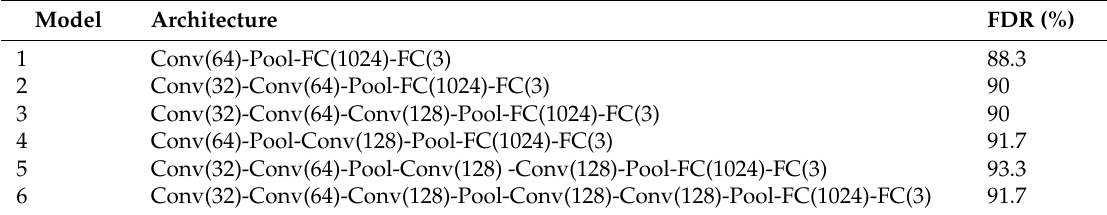
Table 2. The secondary CNN candidate models for fault diagnosis of the R-22